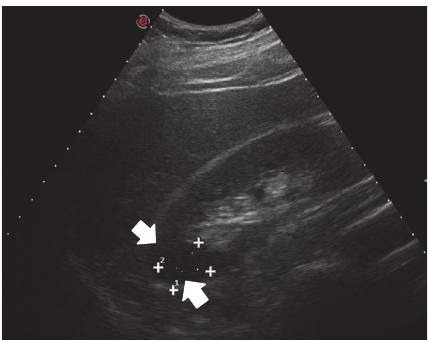
Figure 1: Ultrasonography of the abdomen with convex probe shows at the level of the middle-upper pole of the right kidney a wedge-shaped hypoechoic area, which appears clearly demarcated (arrows).